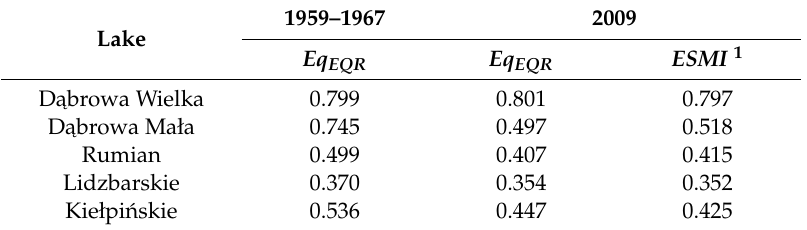
Table 8. Values of the Ecological Status Macrophyte Index ESMI (after Kolada et al. [17]) and Eq EQR in five lakes in the Wel Landscape Park in the 1960s and in the growing season of